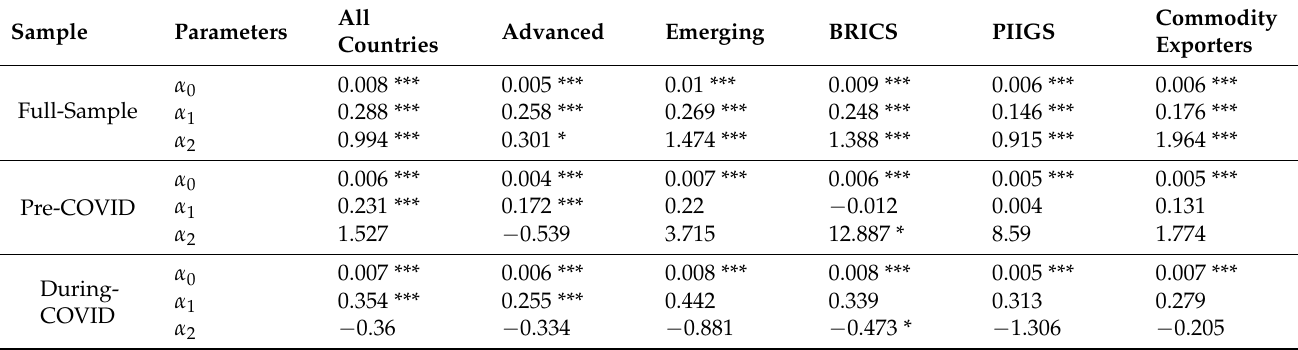
Table 1. Estimates of the Static Herding